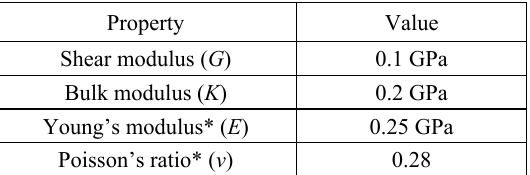
Table 1. Deterministic elastic properties